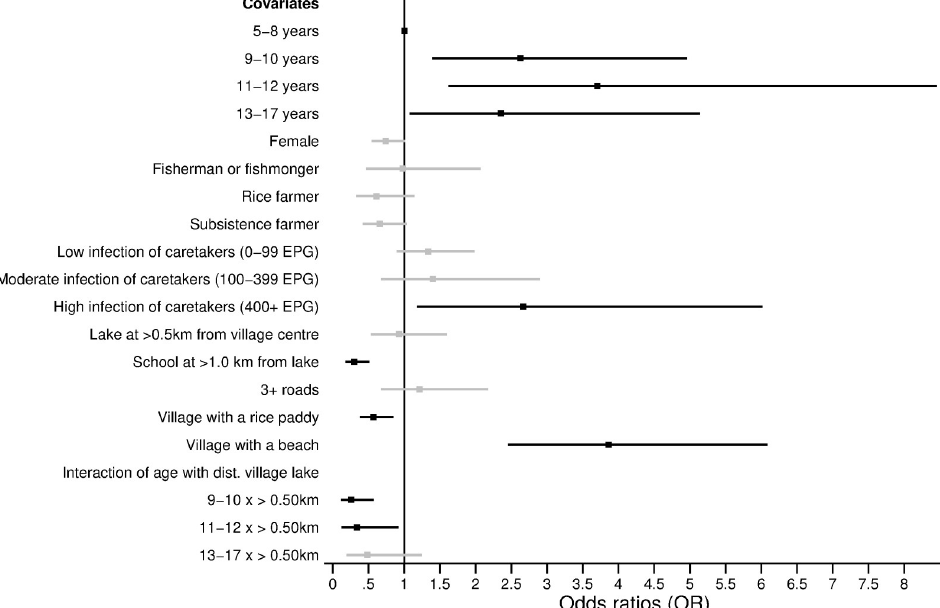
Fig 7. Predictors and modifiers of age-related infection status and intensity in children. Odds ratios (OR) with the corresponding 95% confidence intervals (CI) from the logistic regression model in S7 Table in S1 File are shown. Only covariates that were chosen through likelihood ratio tests are shown in the figure. The black squares (lines) represent the OR (95% CI) for the statistically significant covariates (p-value � 0.05). The grey squares (lines) represent the OR (95% CI) for the non-statistically significant (p-value > 0.05)